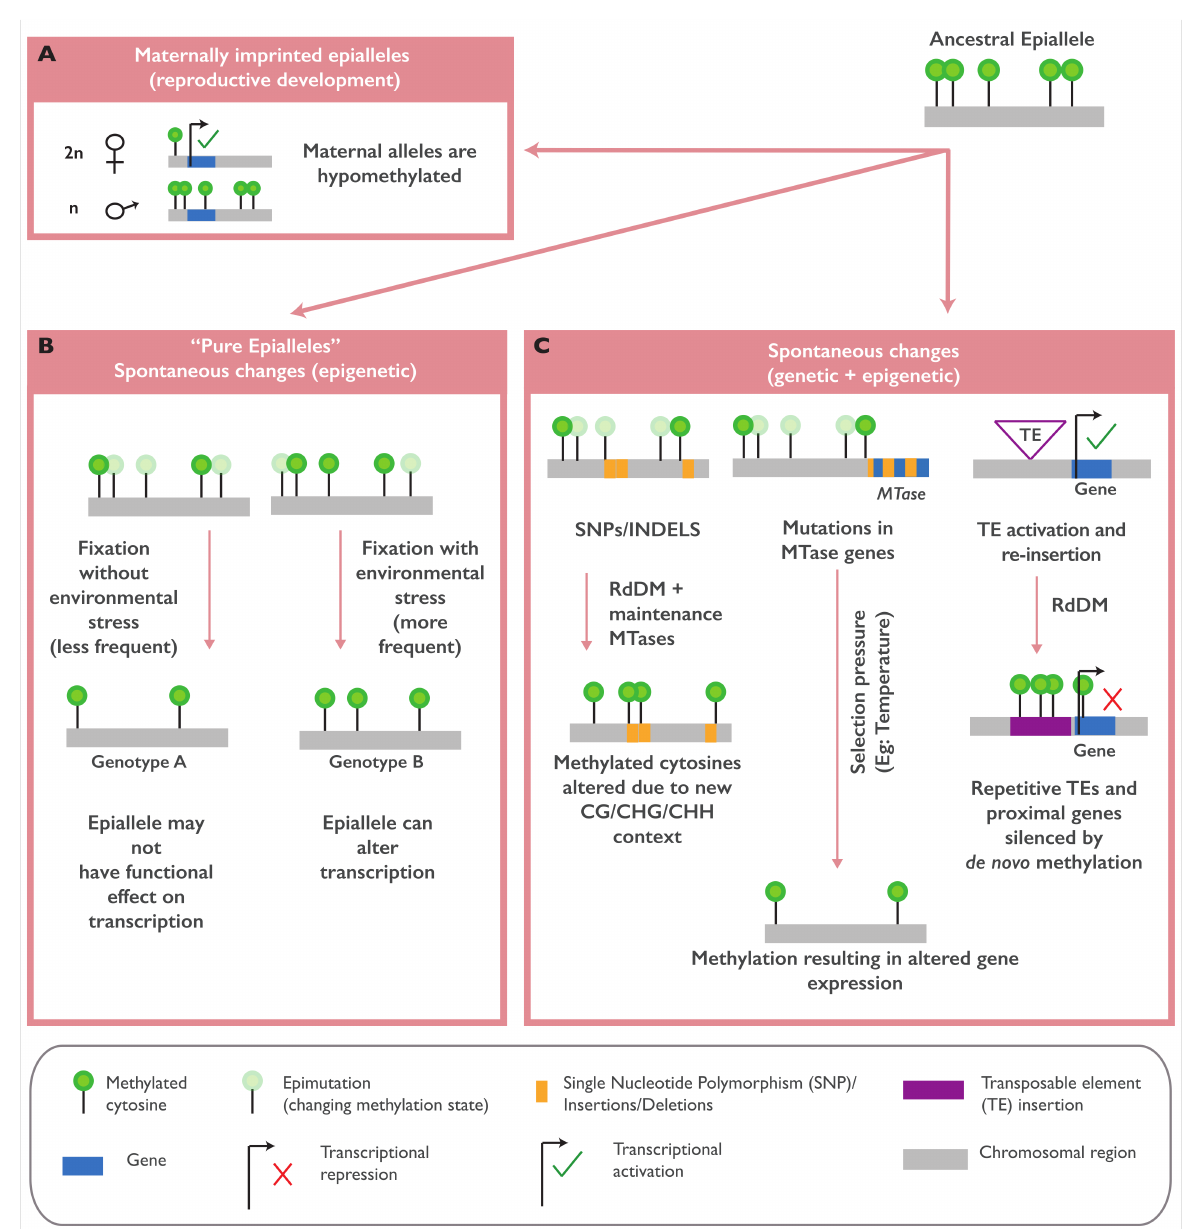
Figure 1. The origins of natural epialleles. Imprinted epialleles can be generated during the reproductive development in wild-type (WT) plants ( A ) where parental allele-specific methylation marks are removed, initiating gene transcription. Spontaneous methylation changes can occur independent of the underlying genetic variation (“pure epialleles”) and may also be subjected to evolutionary fixation ( B ). Mutations in protein-coding genes, including genes involved in the maintenance of DNA methylation (methyltransferases or “MTases”) and the mobilization of transposable elements (TEs), can also recruit methylation marks, which result in the formation of epialleles, as they can influence the proximal gene transcription ( C ). Together, these newly acquired genetic and epigenetic changes may provide an adaptive advantage for the